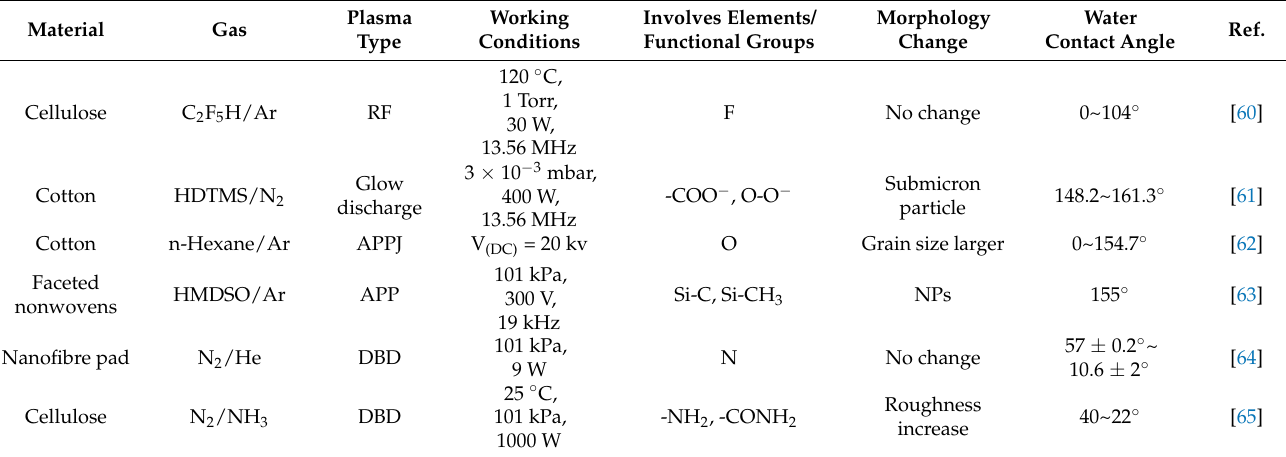
Table 1. Plasma treated fiber surface.